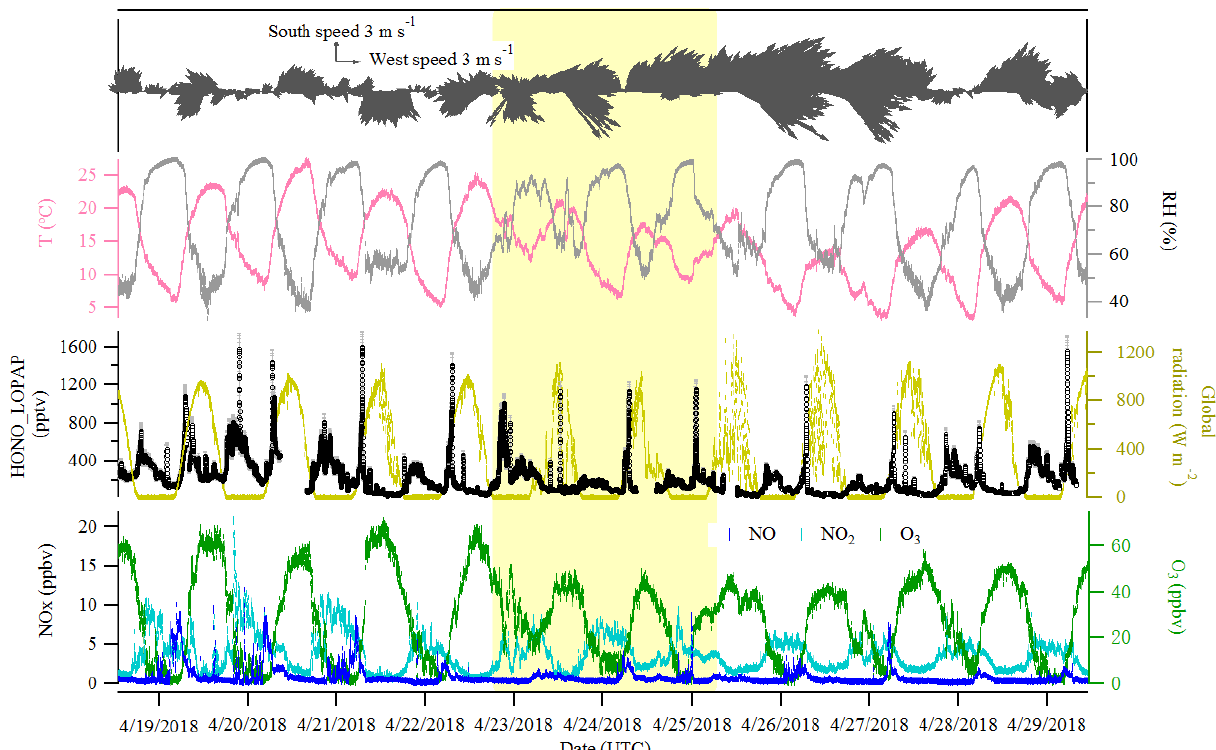
Figure 2. Time series of HONO (LOPAP measurement), NO, NO 2 , O 3 , global radiation, temperature ( T ), relative humidity (RH) and surface wind in Melpitz from 19 to 29 April 2018. The gaps are mainly due to the maintenance of the instruments. The yellow shading indicates two sets of observations discussed in Sect. 3.3. The gray color in the HONO panel indicates the measurement error of HONO